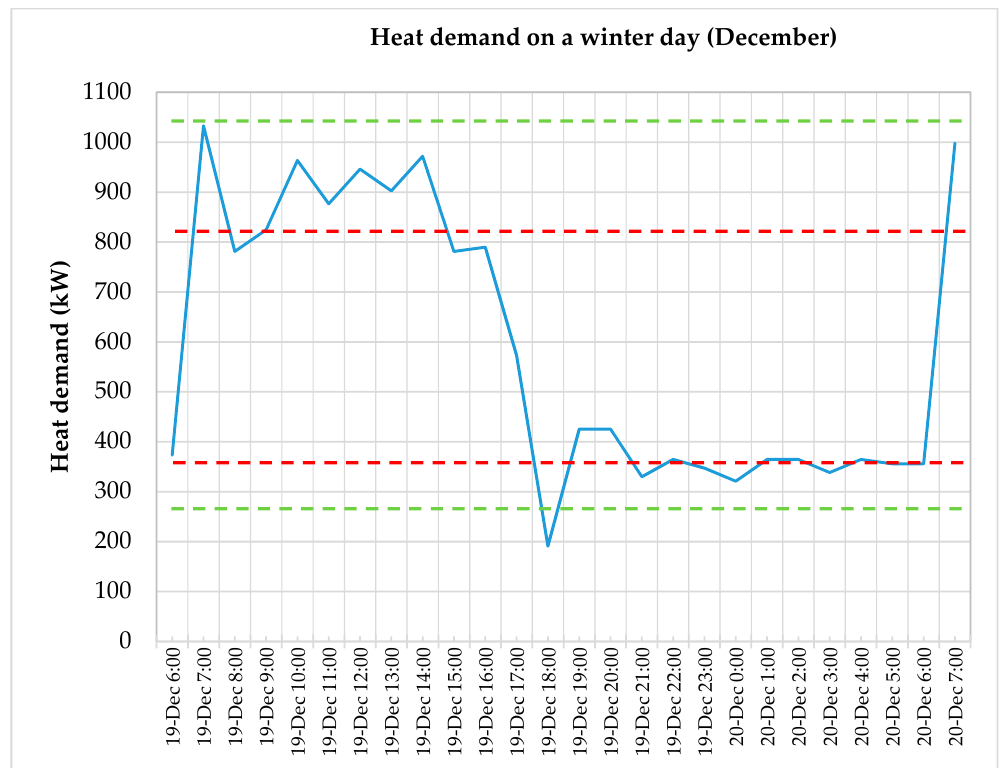
Figure 16. Heat demand on a winter day (December).